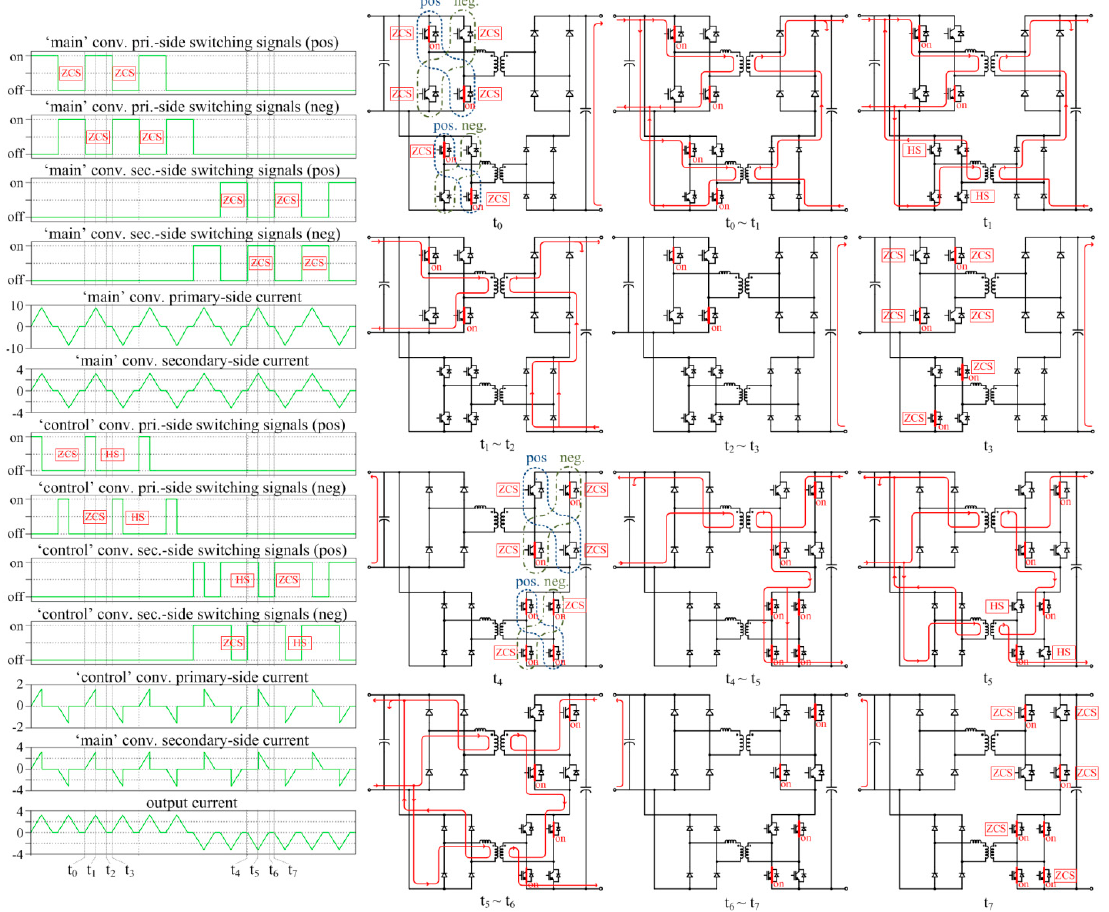
Figure 3. Typical waveforms and current conduction paths according to the switching states.